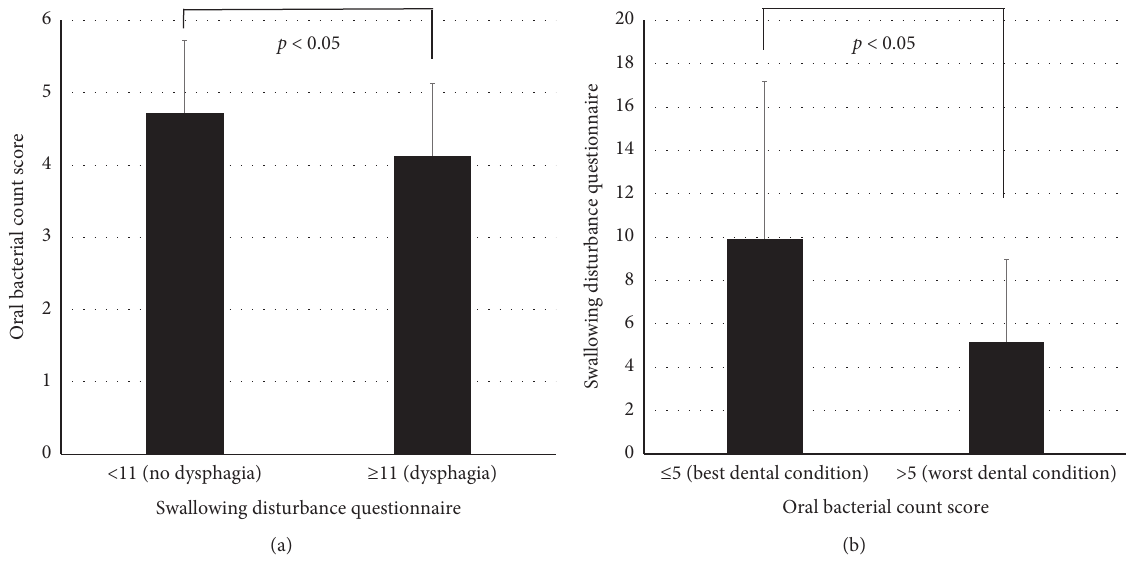
Figure 1: (a) Difference in oral bacteria count (OBC) between patients with an SDQ score of < 11 and ≥ 11 among the next 56 participants. (b) Difference in SDQ scores between patients with OBC exceeding Level 5 or ≤ Level 5 among the next 56 participants.